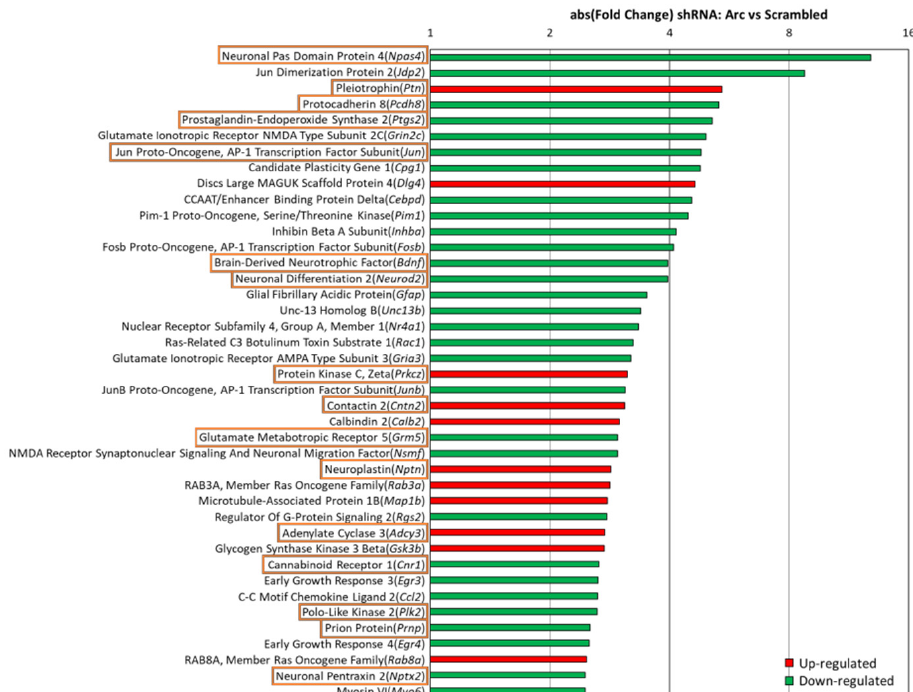
Figure 10. Neuronal plasticity genes regulated by Arc. Neuronal plasticity genes were manually curated in addition to reference to GO terminology from the gene ontology consortium. Neuronal plasticity genes with absolute FC ≥ 2.5 are shown. Genes that are involved in cognition or learning and memory are marked by orange boxes.